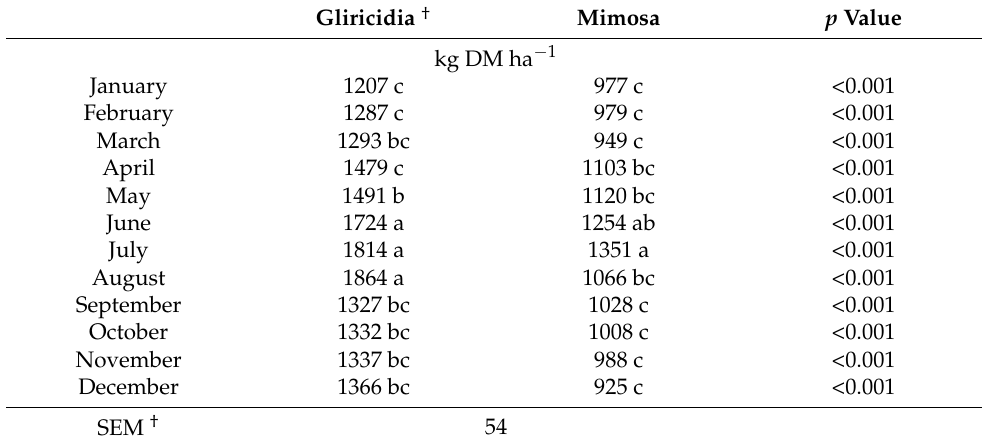
Table 1. Total green herbage mass (kg DM ha − 1 ) for both systems during the experimental period.